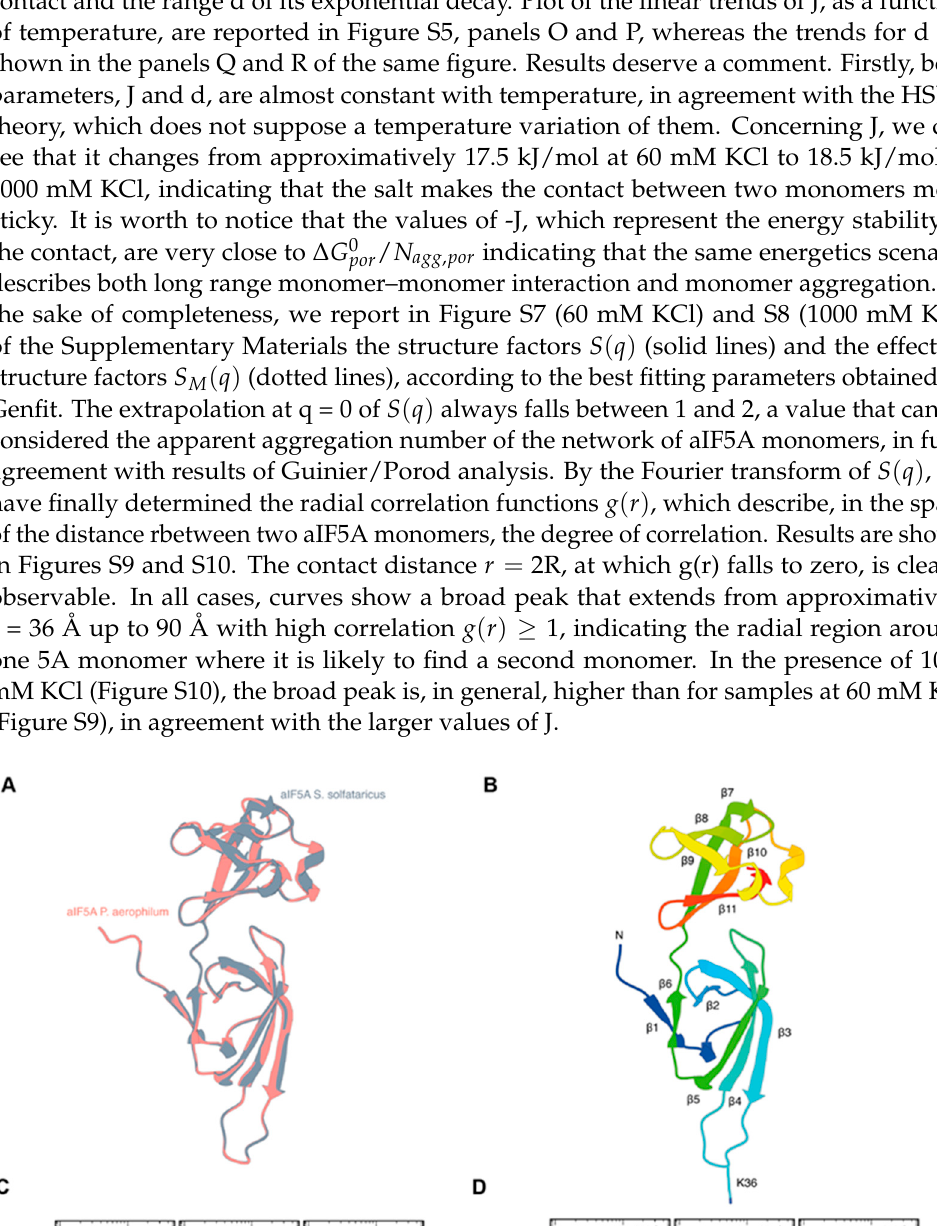
Figure 3. Structural characterization of S. solfataricus aIF5A in solution: ( A ) The structures of mod- eled S. solfataricus aIF5A superimposed on P. arophilum aIF5A (PDB ID 1BKB) are shown in gray and light coral, respectively. The RMSD estimated between the C- α atoms of the structures is 0.120 Å; ( B ) 3D topology of S. solfataricus aIF5A modeled structure. The molecular structure is colored from the N-terminus (dark blue) to the C-terminus (red). In the depiction the location of the lysine 36 that is normally hypusinated is highlighted; ( C , D ) SAXS curves shown in log–log plots of the N-His- aIF5A. Each frame reports data at the same temperature, as indicated. The protein concentration of each sample is: 0.5 mg/mL (blue); 1 mg/mL (green); 2 mg/mL (yellow); 5 mg/mL (orange); 10 mg/mL (red). Samples in panel C contain 60 mM KCl, and the ones in panel D contain 1000 mM KCl. Error bars are reported every 10 points, for clarity Solid black lines are the best fit obtained with GENFIT (Equation (S7)); ( E ) Kratky plots of data reported in panel C . Curve have been divided by the protein concentration; ( F ) Guinier plot of data reported in ( C ). The solid black lines in panel f are the best Guinier/Porod fits (Equation (S1)), whereas the dashed black lines are the Guinier law contribution